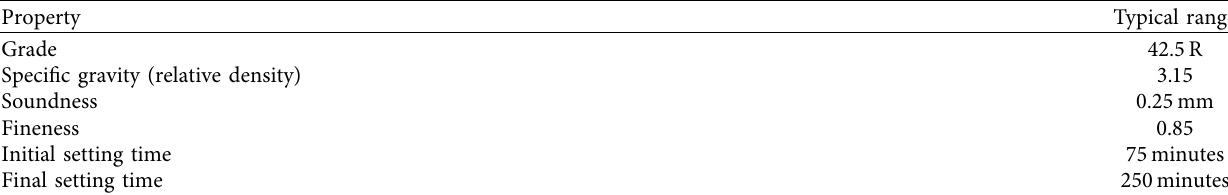
Table 3: Summary of cement proprieties.